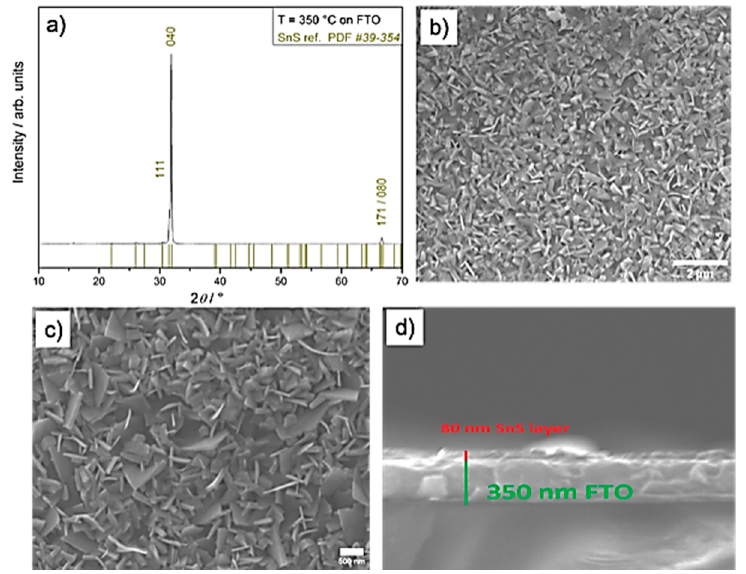
Figure 6. ( a ) GI-XRD (recorded in grazing incidence mode) pattern of SnS deposited on FTO substrate at T =350 °C. ( b ) and ( c ) SEM top view of SnS on FTO, ( d ) SEM cross-section of SnS on at T = 350 ◦ C. ( b , c ) SEM top view of SnS on FTO, ( d ) SEM cross-section of SnS on FTO (SnS layer FTO (SnS layer around 80 nm) . around 80